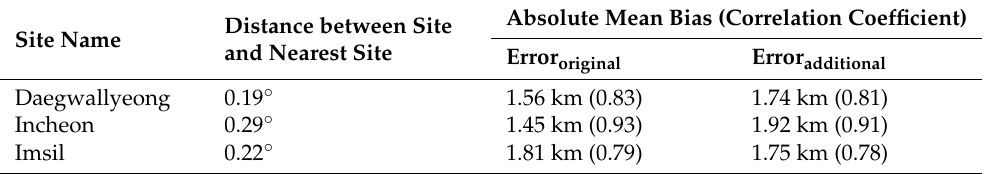
Table 5. Summary of visibility estimation errors of model original and model additional